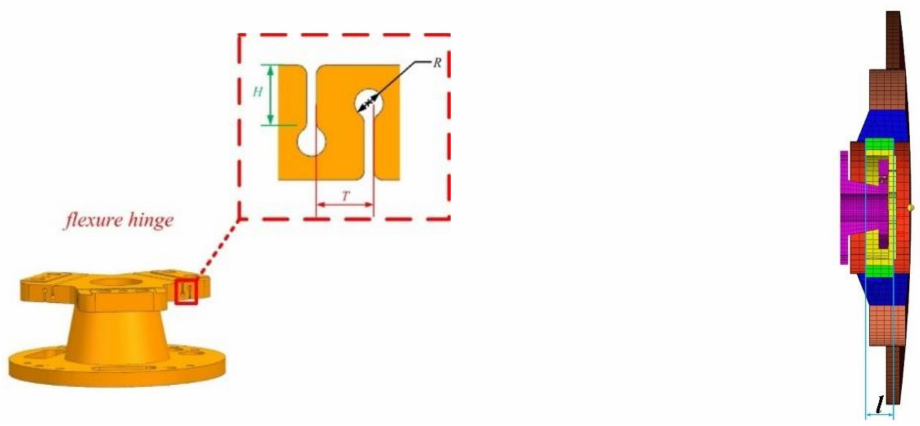
Figure 7. The parameters of the